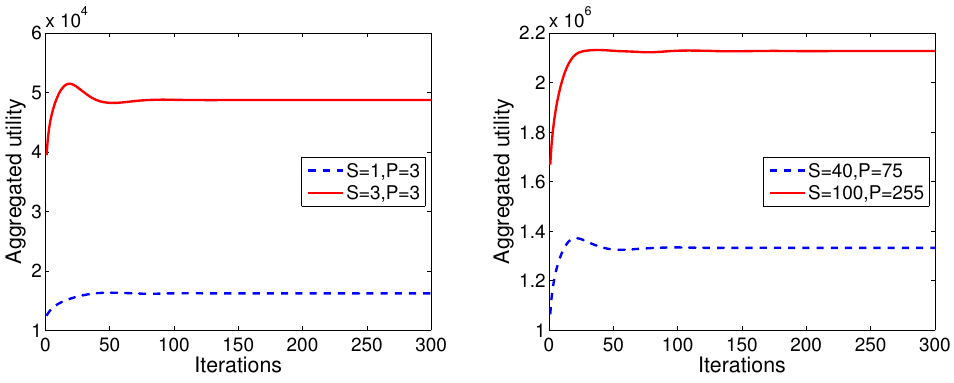
Figure 8. Performance of the resource allocation algorithm for application deployment in different